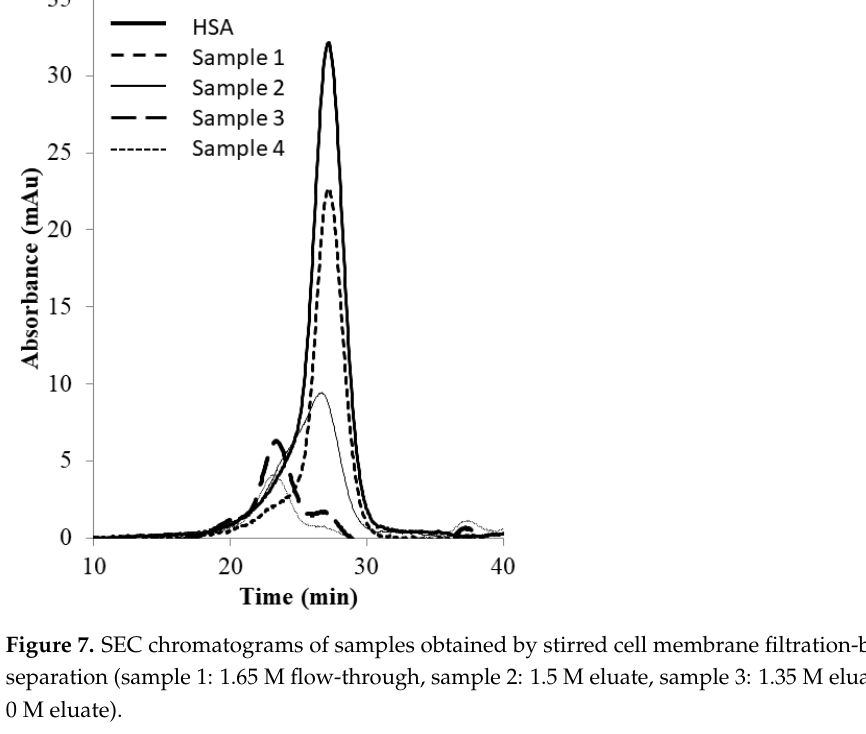
Figure 9. Image of Coomassie-blue-stained SDS-PAGE gel of samples obtained by tangential flow- based hybrid separation (lane 1: MW markers, lane 2: HSA, lane 3: PEG reaction mixture, lane 4: peak 1 (1.65 M flow-through), lane 5: peak 2 (1.5 M eluate), lane 6: peak 3 (0 M eluate)).